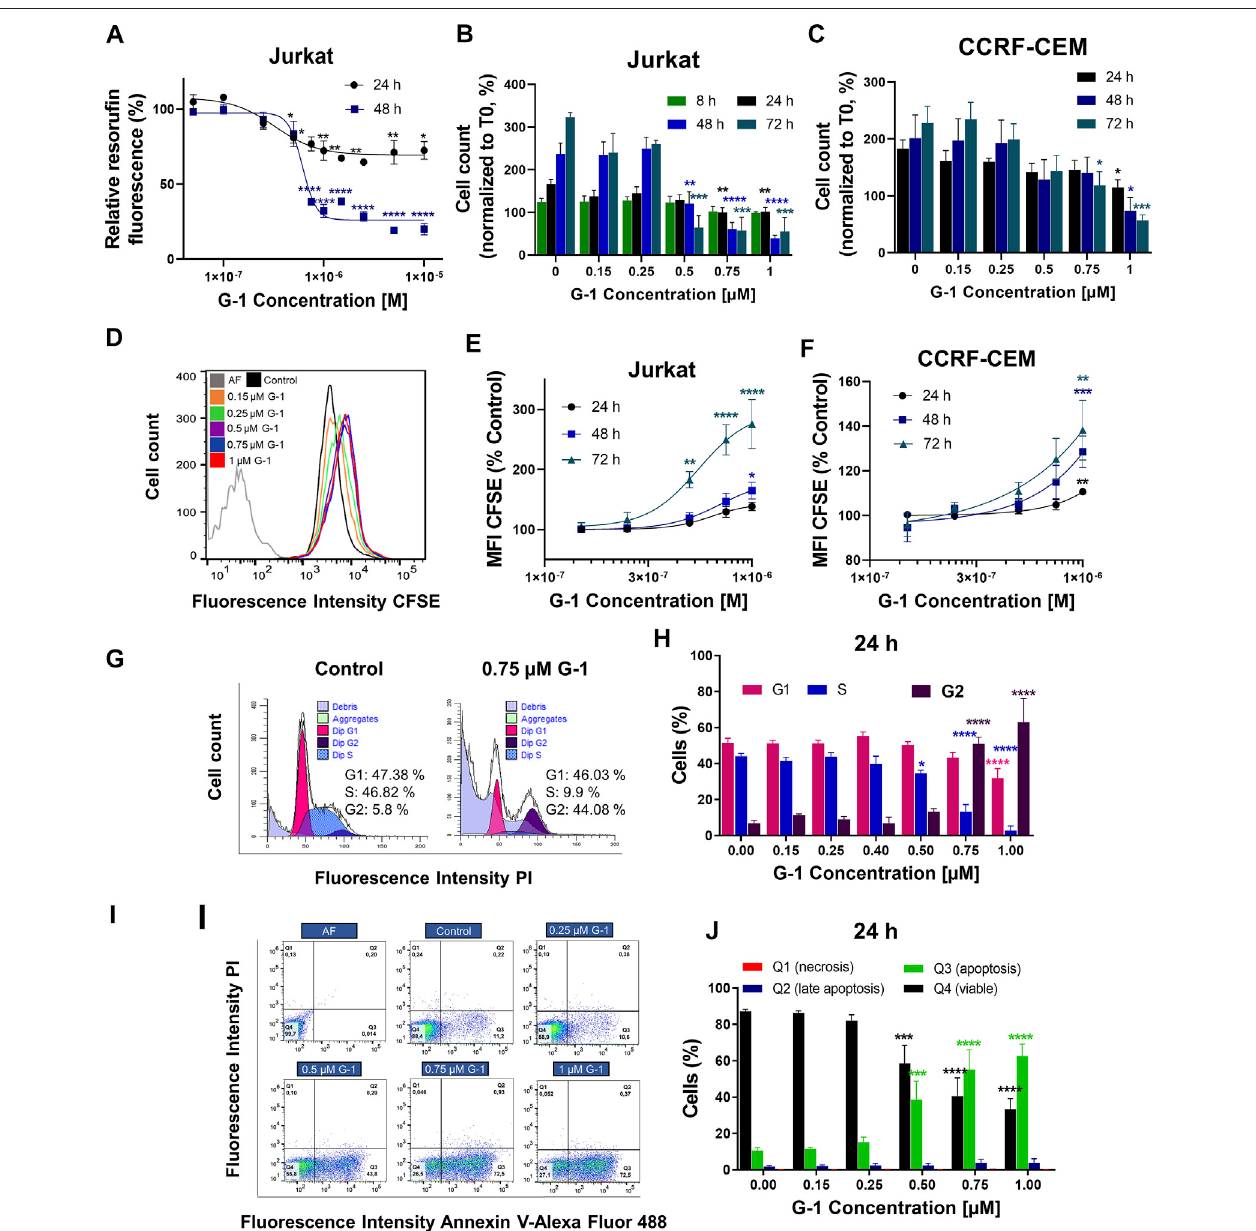
FIGURE 1 | G-1 possesses antileukemic properties. Cells were incubated in the presence of growing concentrations of G-1 for the indicated periods of time. (A) Cell viability was evaluated by the resazurin-based metabolic assay, as a function of G-1 concentration. Data (resoru fi n fl uorescence intensity, arbitrary units) of treated samples are normalized to the vehicle-treated control. (B,C) Cell viability was evaluated by live cell count (trypan blue exclusion test) at indicated time points. Data are normalized tothe initial time point (0 h). (A – C) Dataare mean ± SEM; N ≥ 3; * p < 0.05, ** p < 0.01, *** p < 0.001,**** p < 0.0001;one-wayANOVAwith Dunnett post hoc testing. (D) ArepresentativehistogramofchangesintheCFSE fl uorescenceintensityofJurkatcellsgrowinginthepresenceofincreasingconcentrationsofG-1after 72 h oftreatment; theshift ofthe mean fl uorescence peak (MFI) to theleft re fl ects cell proliferation. Theauto fl uorescent population (AF, without CFSE staining) is shown. (E,F) MFI of CFSE of Jurkat (E) and CCRF-CEM (F) cells treated with G-1 normalized to control (untreated) cells as a function of G-1 concentration. Data are mean ± SEM;N ≥ 3; * p < 0.05, ** p < 0.01, *** p < 0.001,**** p < 0.0001;one-way ANOVAwith Dunnett posthoc testing. (G) RepresentativeModFit histograms ofuntreatedcells andcellsincubatedwithG-1(0.75 μ M,24 h).TheG0/G1peakispink,G2/Mpeakispurple,SphasebetweenG0/G1andG2/Misblue,andsubG1damagedpopulation islight-purple. (H) Bar chartsshowingthepercentage oftheJurkat cellsindifferentsubpopulationscorrespondingtoG1,S, and G2phasesat 24 h ofG-1treatment. (I) Representativedotplotsobtainedby fl owcytometryofJurkatcellstreatedwithG-1during24 h.Populationsareasfollows:Q1necrotic(AnnexinV/AlexaFluor488 − PI + ), Q2 late apoptotic/necrotic (Annexin V/AlexaFluor488 + PI + ), Q3 apoptotic (Annexin V/AlexaFluor488 + PI − ), and Q4 viable (Annexin V/AlexaFluor488 − PI − ). (J) Bar charts showingthepercentageofcellsinQ1 – Q4populationafter24 hofG-1treatment. (H,J) Dataaremean±SEM; N =3;* p < 0.05,*** p < 0.001,**** p < 0.0001.Comparison between control (without treatment) and G-1 – treated samples was made by two-way ANOVA with Dunnett post hoc testing.